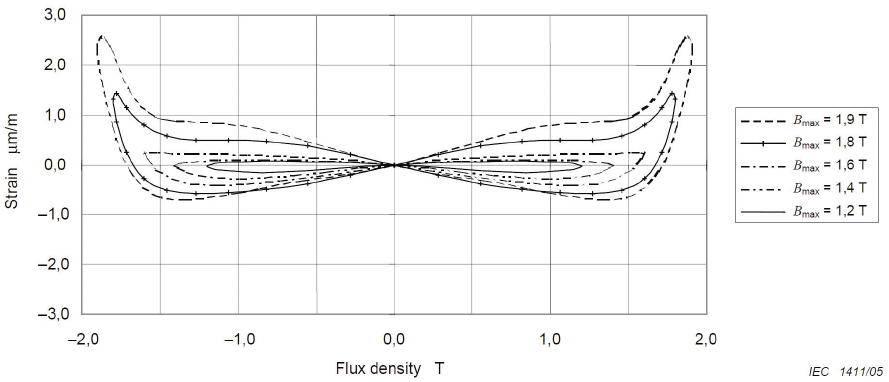
Figure 3. Example curves showing relative change in length for one type of core lamina- tion during complete cycles of applied 50Hz AC induction up to different peak flux densities ( B max = 1.2T–1.9T)